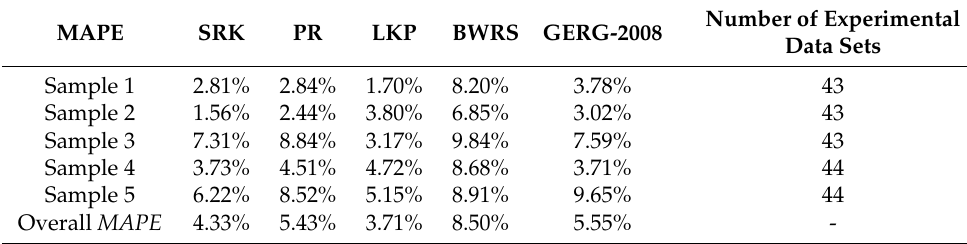
Table 10. MAPE s of experimental and calculated results in the dew point